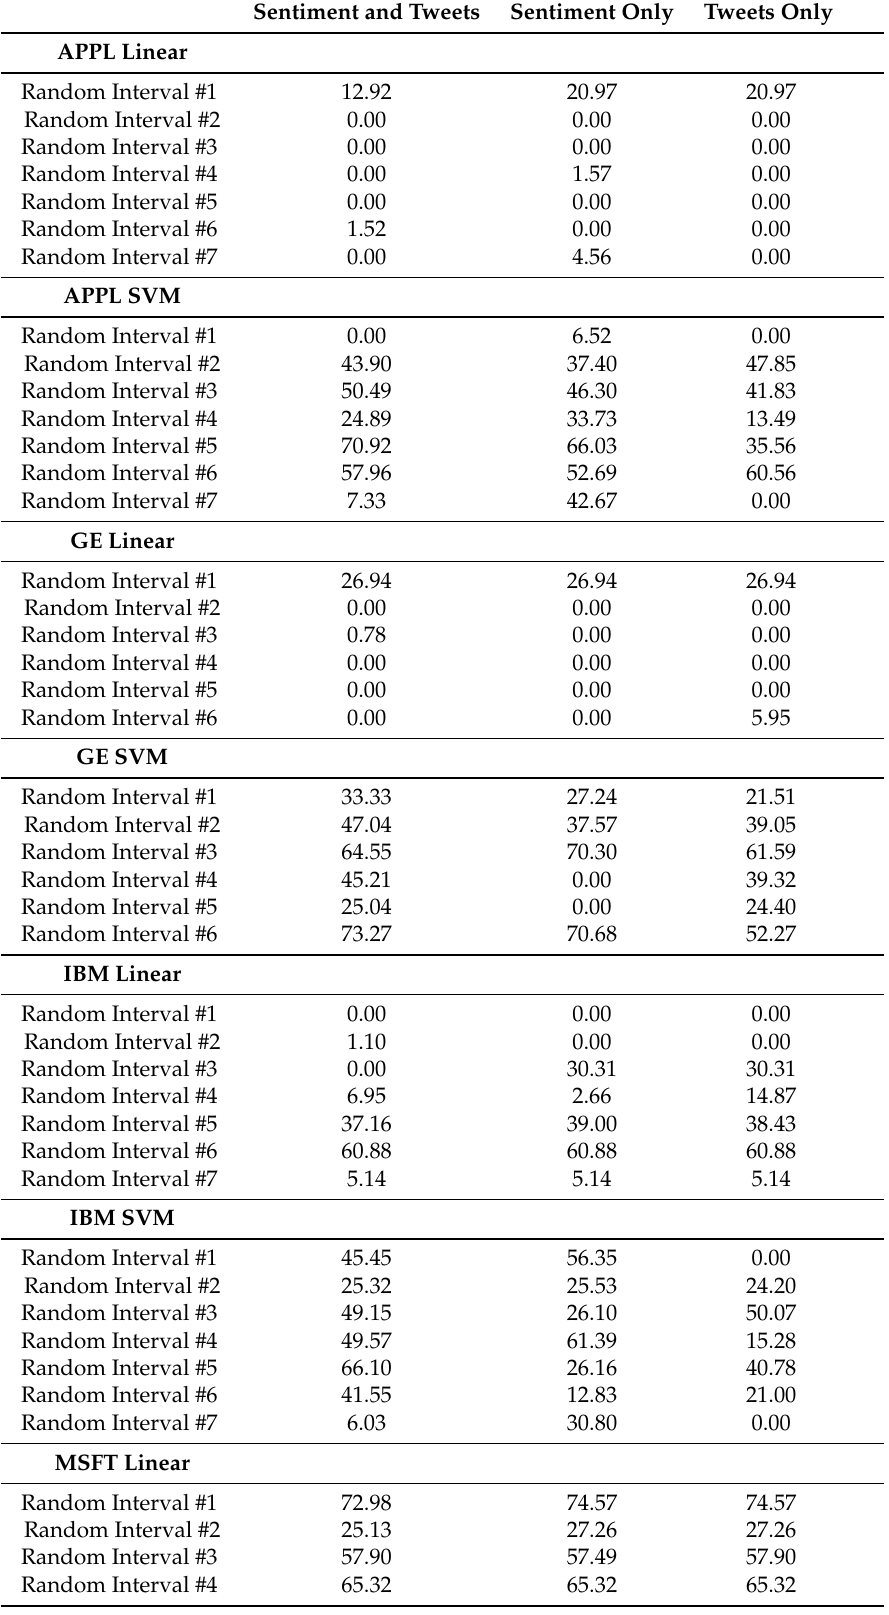
Table 6. The improvement rates of the next closing price of the five companies using random intervals, without using rules (in